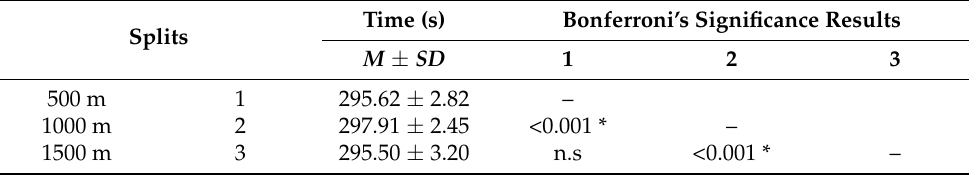
Table 2. Summarized post hoc Bonferroni’s and Scheff é ’s tests analysis of the 500 m split of the 1500 m swimming performance. Time Splits